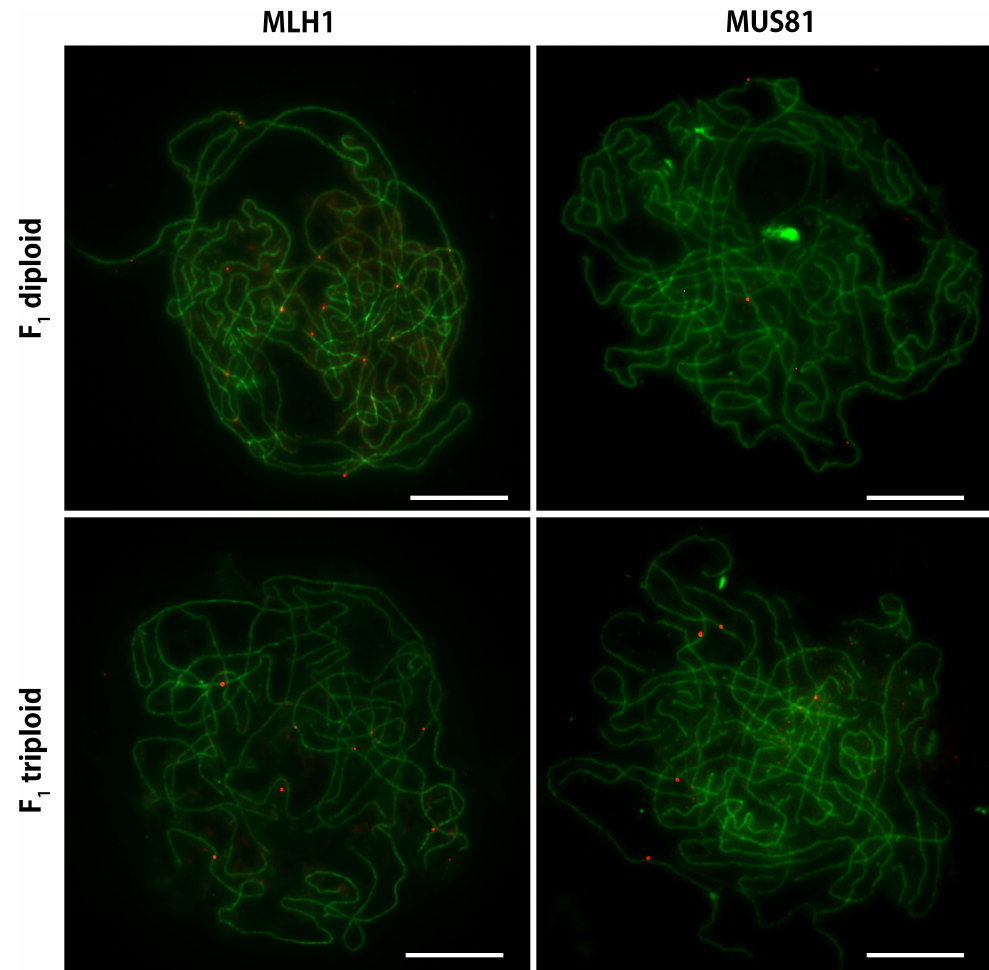
Figure 5. Immunolocalization of the MLH1/ZYP1 and MUS81/ZYP1 at pachytenes of F 1 diploid hybrid (2 n = 2 x = 8F + 8C) and F 1 triploid hybrid (2 n = 3 x = 16F + 8C). Bar = 10 µ